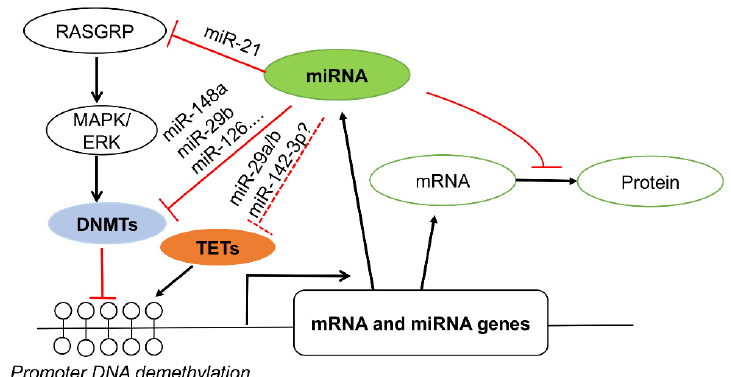
Figure 2. Interplay of miRNAs and DNA methylation in gene expression in SLE. Several dysregulated miRNAs in lupus such as miR-21, miR-148a, miR-29b, and miR-126 can target DNMTs directly and indirectly [88–90], leading to gene promoter hypomethylation and activation of mRNA and miRNA genes expression. On the other hand, increased miRNA expression may suppress target mRNA translation to protein. However, whether the dysregulated miRNAs in SLE such as miR-29a/b [82,90] and miR-142-3p [91] target TETs to regulate gene methylation remains unknown (dashed line).